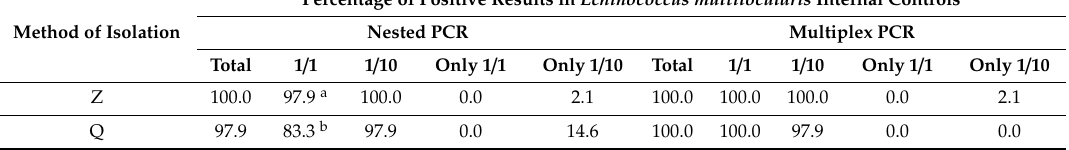
Table 2. Results in Echinococcus multilocularis internal controls obtained in nested PCR and multiplex PCR.